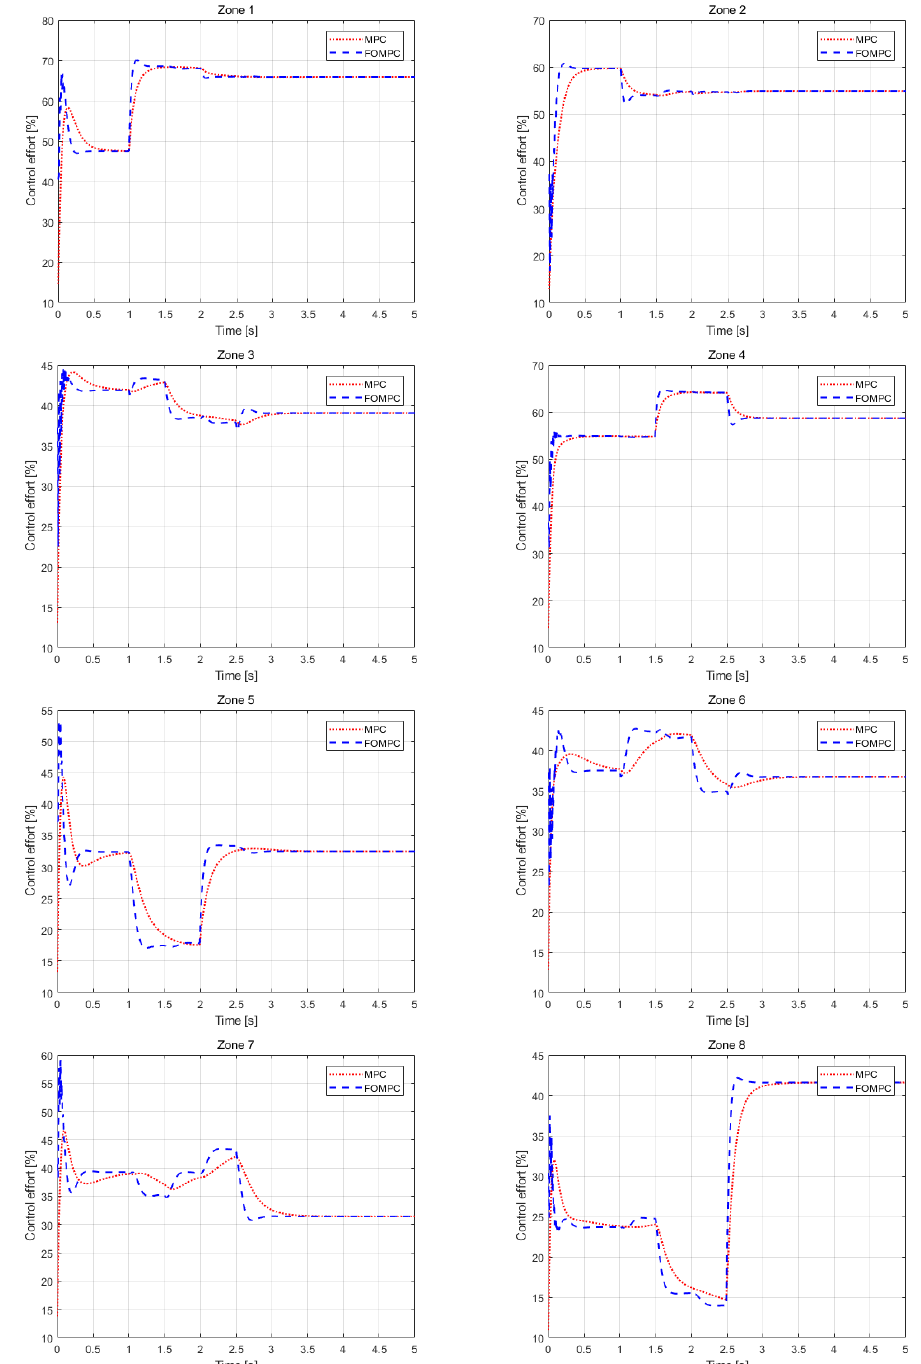
Figure 5. Control effort of multiple lighting controls with MPC and FOMPC in reference tracking simulation.